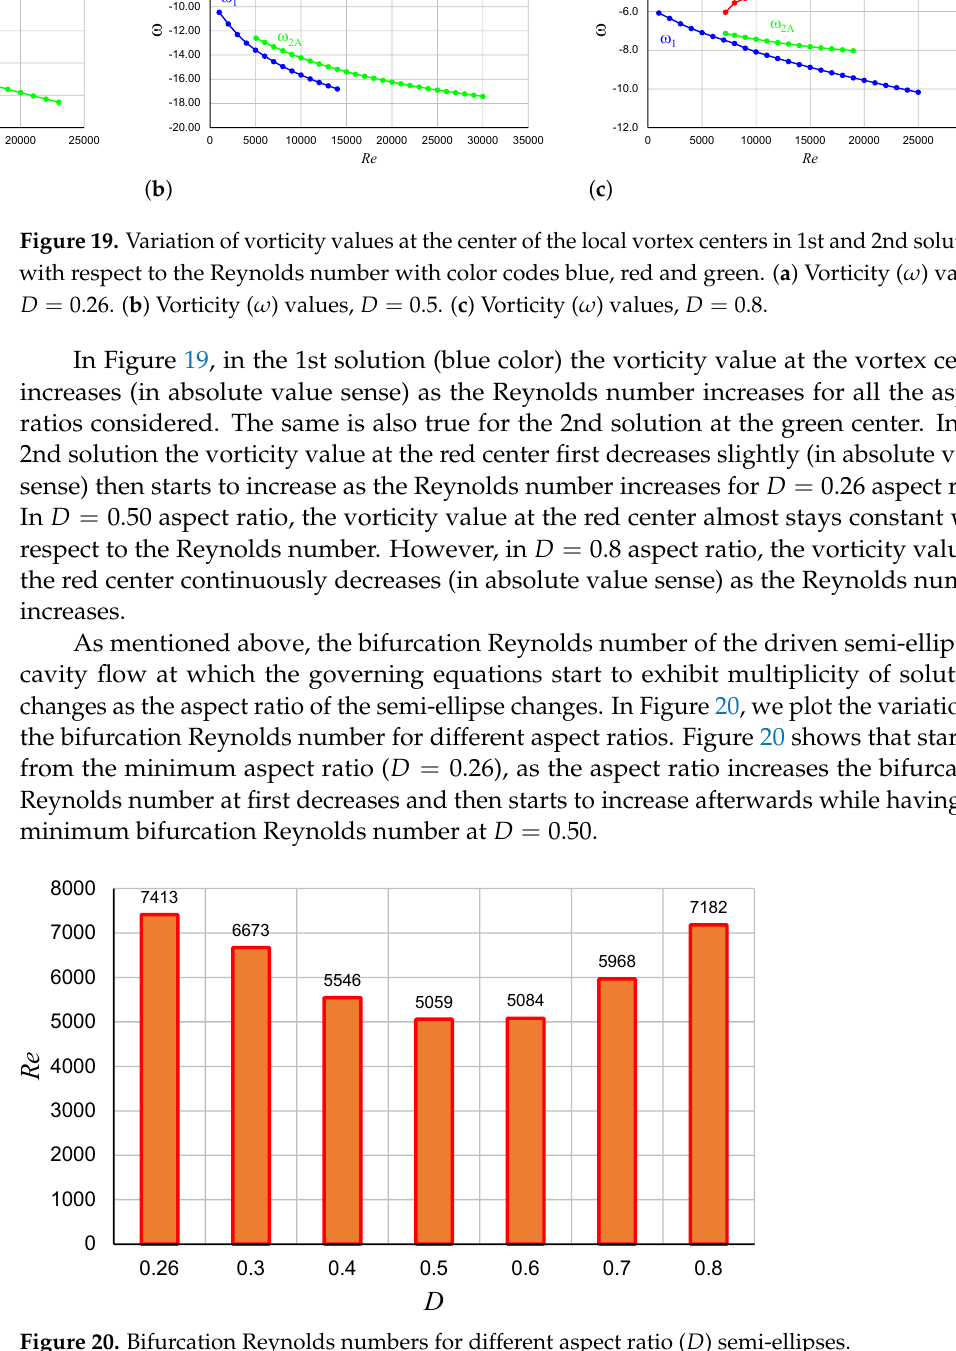
Figure 20. Bifurcation Reynolds numbers for different aspect ratio ( D )